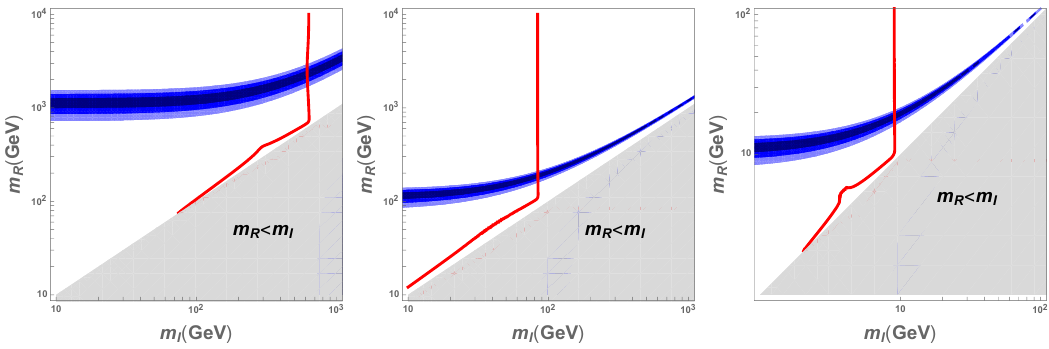
Figure 13 . The C (cid:22); NP for b s(cid:22)(cid:22) anomaly (blue region) and the relic density of the dark matter 9 ! (red line) in ( m I ; m R ) plane. The dark blue, blue, and light blue region represent 1, 2, and 3 (cid:27) allowed region, respectively. From the left panel we take m Z 0 = 700 ; 100 ; 10 GeV. We (cid:12)xed q X = 2, (cid:11) Z 0 = 0 : 1, (cid:21) s (cid:21) (cid:3) = 0 : 2, and M D = 1 TeV. The other (cid:12)xed parameters are the same with those for b (cid:12)gure 10. The grey region is unphysical because m R < m I .